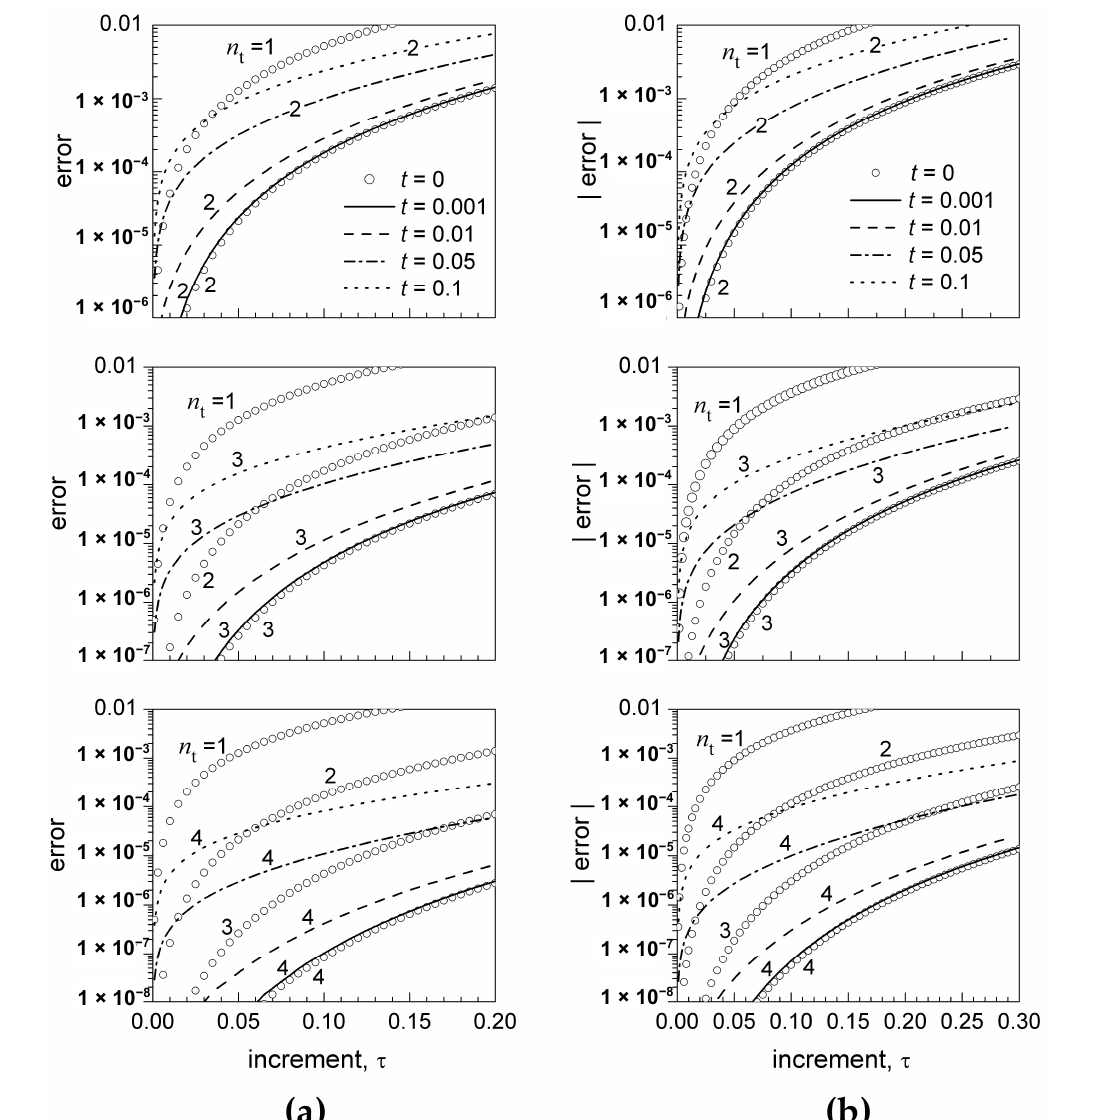
Figure 2. ( a ) Detail of Figure 1a in the range 0 < τ ≤ 0.2; ( b ) detail of Figure 1b in the range 0 < τ ≤